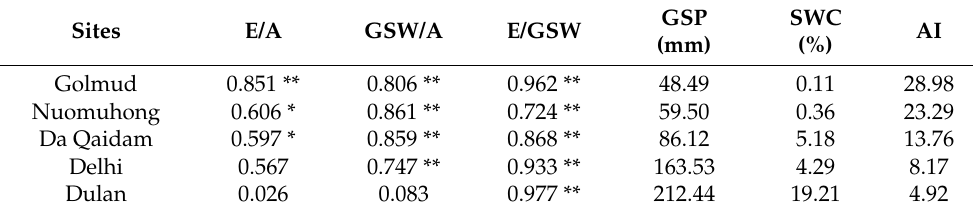
Table 3. Variation in the relationship among plant functional traits with the drought gradient.